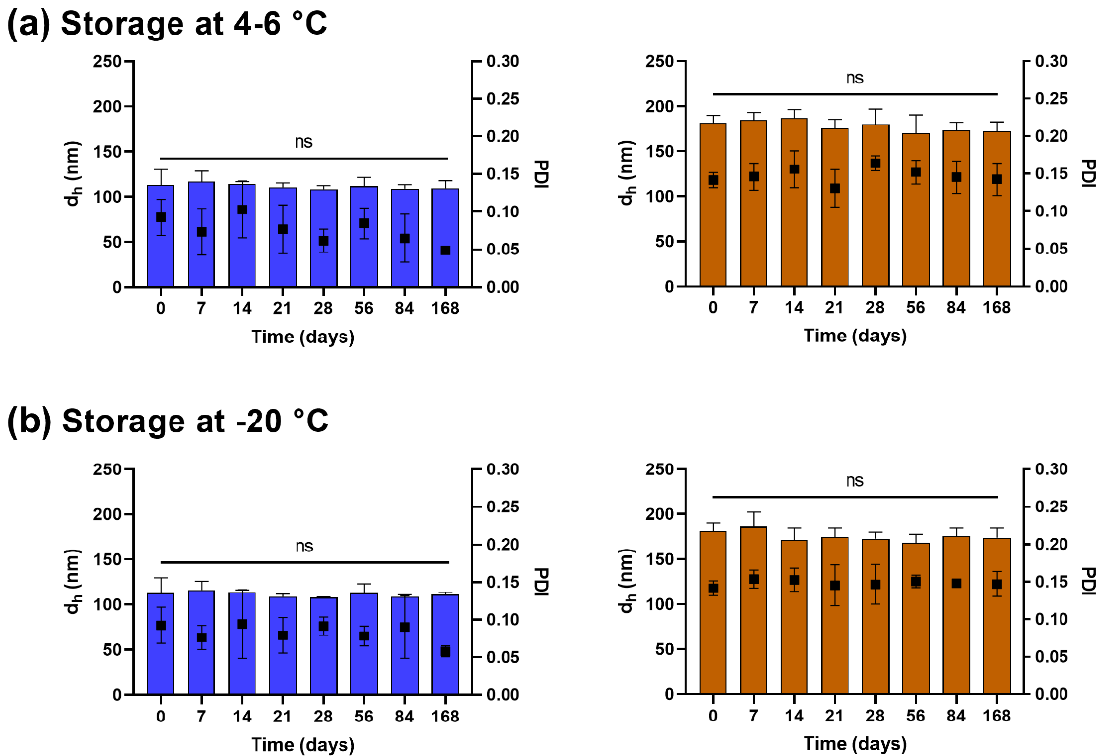
Figure 2. Colloidal stability analysis of rehydrated Cu 2+ -liposomes (blue) and Cu(DDC) 2 -liposomes (brown) after storage in lyophilized form at ( a ) 4–6 ◦ C and ( b ) − 20 ◦ C. Aliquots of lyophilized Cu 2+ -liposomes and Cu(DDC) 2 -liposomes were stored for up to 168 days and resuspended, and the hydrodynamic diameter (d h ; bars) and polydispersity index (PDI; squares) were determined via dynamic light scattering. Data are expressed as the mean ± standard deviation (n = 3; 1-way ANOVA with Dunnett’s multiple comparison test, ns = not significant p > 0.05).